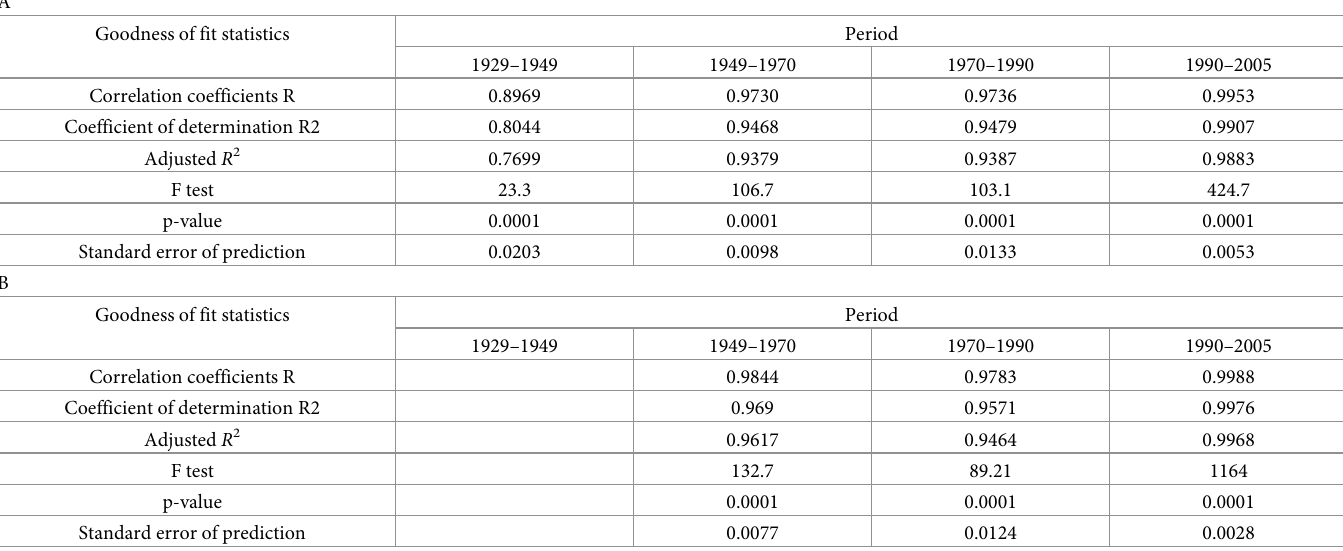
Table 3. Parameters of goodness of fit for models without alcohol (A) and with alcohol (B).